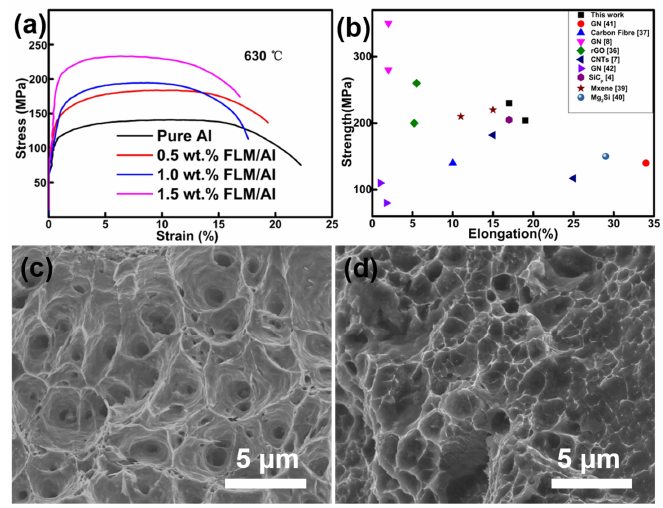
Figure 5. ( a ) Engineering stress–strain curves of bulk samples sintered at 630 ◦ C, ( b ) comparison of tensile strength versus total elongation of composites of AMCs, ( c , d ) fracture surfaces of pure Al and 1.5 wt.% FLM/Al sintered at 630 ◦